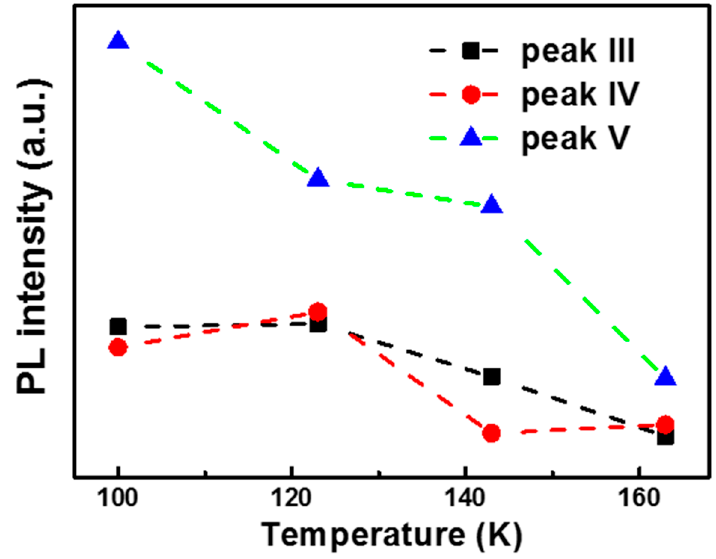
Figure 4. Temperature-dependent PL intensity of peaks III, IV, and V for the strained GaSe flake.